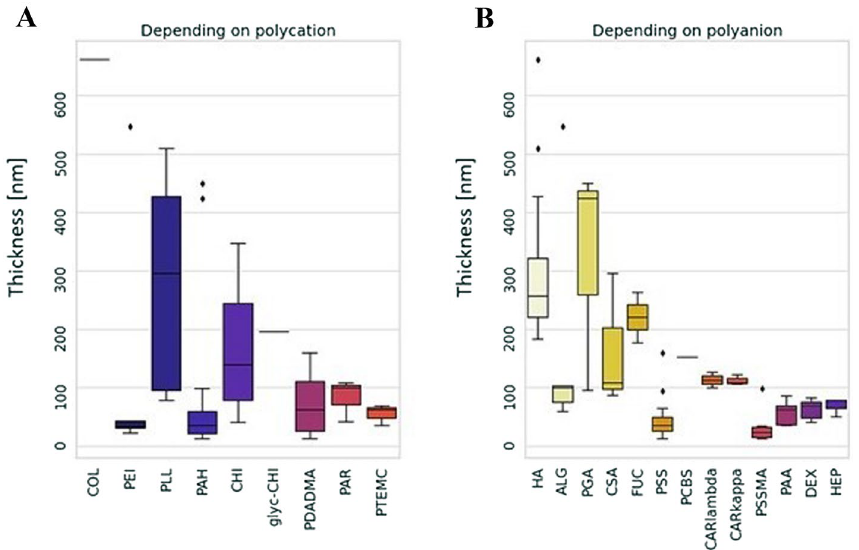
Figure 2. Boxplots showing the distribution of the thickness values in the coatings made of different polymers. ( A ) Thickness depending on polycations. ( B ) Thickness depending on polyanions. COL: collagen, PEI: polyethylenimine, PLL: poly(L-lysine), PAH: poly(allylamine hydrochloride), CHI: chitosan, glyc-CHI: glycol-chitosan, PDADMA: poly(diallyldimethylammonium chloride), PAR: poly(L-arginine), PTEMC: poly(trimethylammonium ethyl methacrylate chloride), HA: hyaluronic acid, ALG: alginate, PGA: poly(L- glutamic acid), CSA: chondroitin sulfate, FUC: fucoidan, PSS: poly(styrene sulfonate), PCBS: poly[1-[4-(3- carboxy-4-hydroxyphenylazo)benzenesulfonamido]-1,2-ethanediyl, sodium salt, CARlambda: λ-carrageenan, CARkappa: κ-carrageenan, PSSMA: poly(4-styrenesulfonic acid-co-maleic acid), PAA: poly(acrylic acid), DEX: dextran, HEP: heparin.